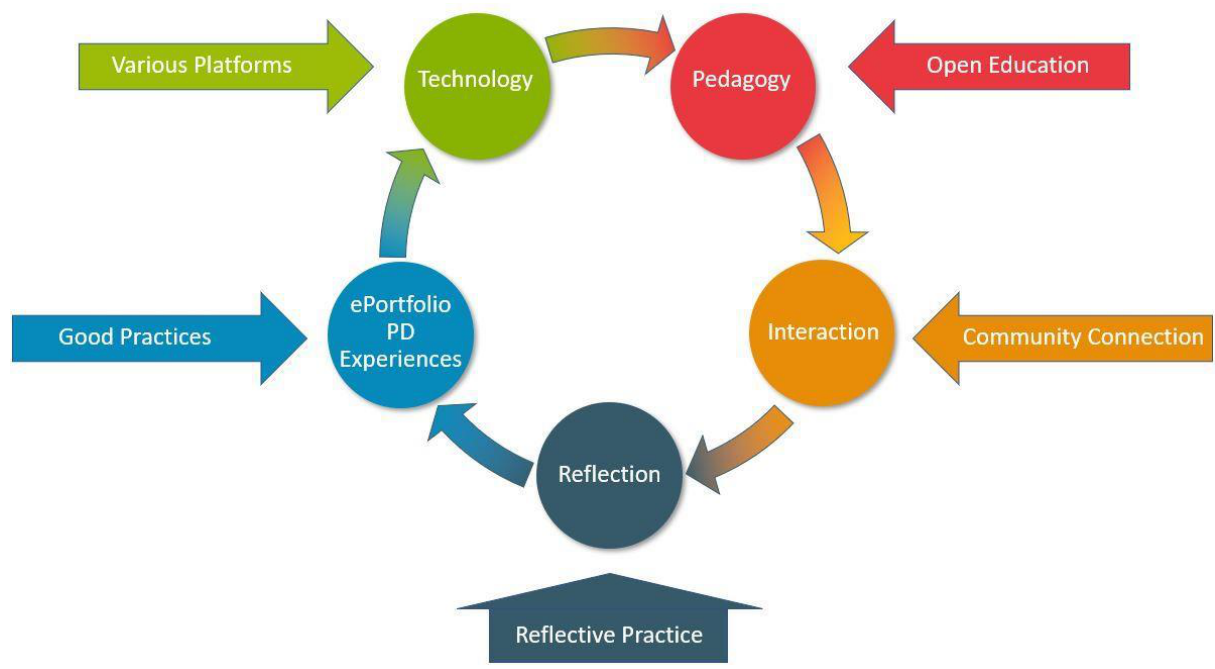
Figure 1: The need for further studies Adapted from Zuba Prokopetz (2020a,